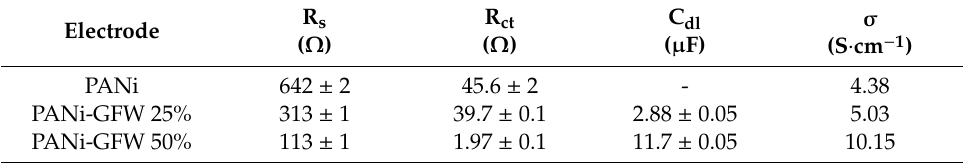
Table 1. Electrochemical parameters extracted from fitting the EIS data on modified